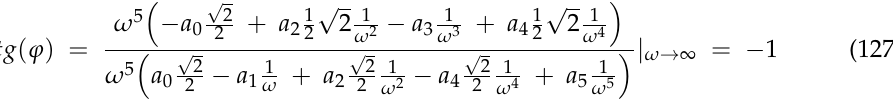
Figure 31. Polynomial basis j 1/3 –sector (cid:4672) 𝝅 are out of the sector, the system is stable.